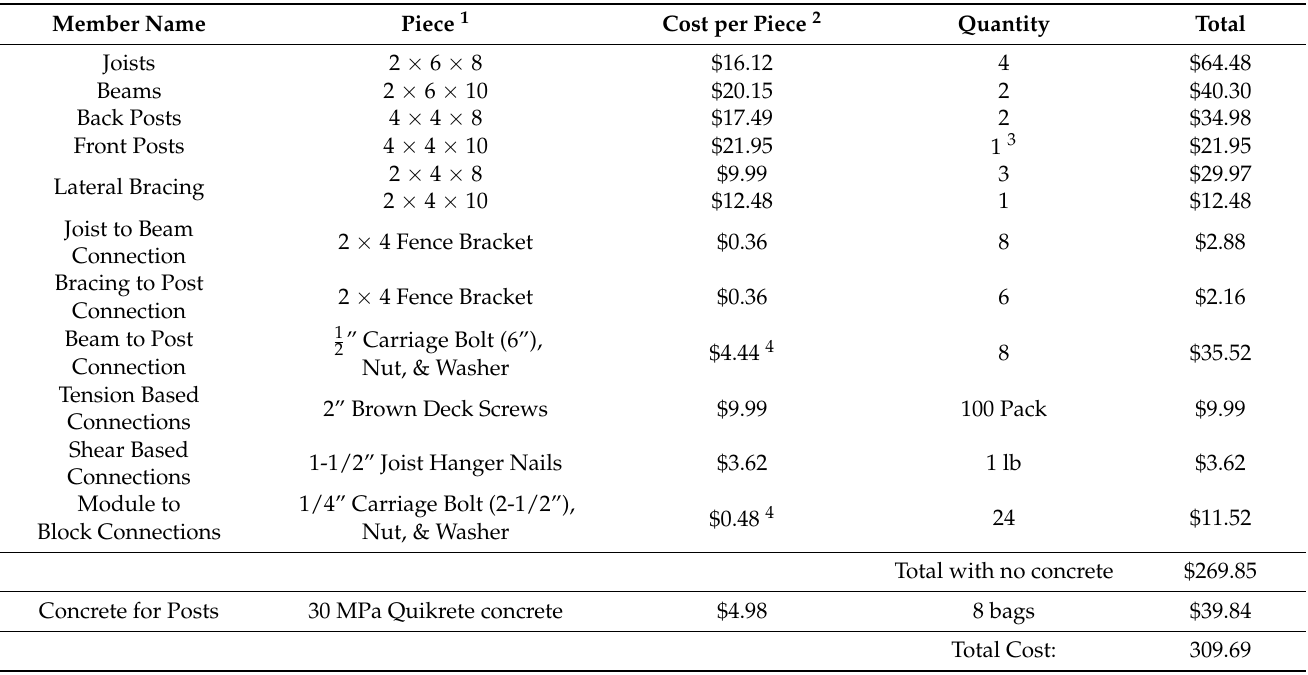
Table 5. 10 Degree Fixed Rack List of Materials for Lom é Togo if purchased in Canada